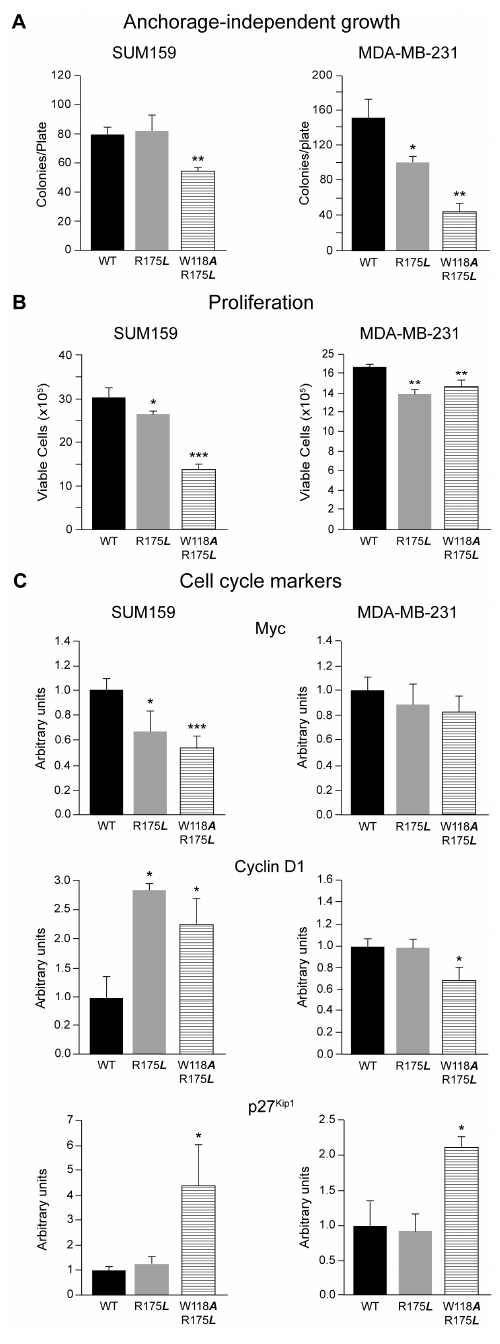
Figure 3. Modulation of anchorage-independent growth and cell proliferation by expression of c-Src variants in SUM159 and MDA-MB-231 cells. ( A ) Colony formation in soft-agar was employed to determine the effect of c-Src variants expression in SUM159 and MDA-MB-231 cells in anchorage-independent growth (see Materials and Methods). Each experiment was measured in triplicates ( n = 3) and repeated three times. Results were expressed as the mean ± SD of the number of colonies/plate, * p < 0.5, ** p < 0.01. ( B ) Cell proliferation of SUM159 and MDA-MB-231 expressing c-Src variants was determined by the trypan blue exclusion assay (see Materials and Methods), * p < 0.5, ** p < 0.01, *** p < 0.001. ( C ) Quantitative analyses of cell proliferation markers Myc, cyclin D1, and p27 expression by WB in SUM159 and MDA- MB-231 cells conditionally expressing c-Src variants. Results represented data obtained from three independent WB ( n = 3) using either β -Actin, α -Tubulin, or GAPDH as a loading control expressed as a percentage of the mean ± SD, and were referred to those obtained from cells expressing c-Src-wt considered as 1. The statistical significance is referred to cells expressing c-Src-wt, * p < 0.5, *** p <